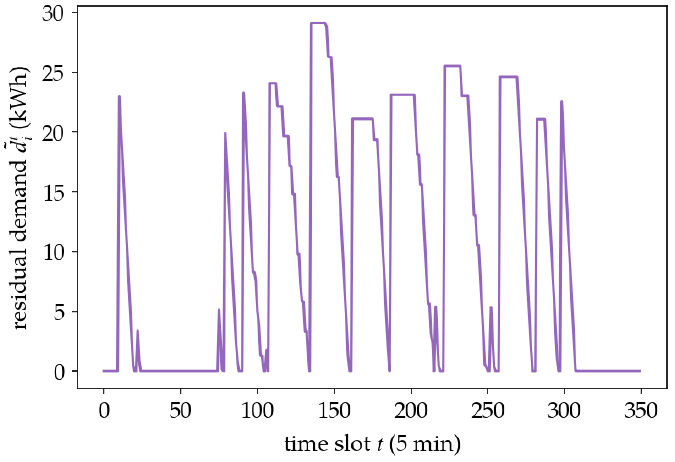
Figure 22. Residual demand for a single charger for the first 350 time slots (three-day episode